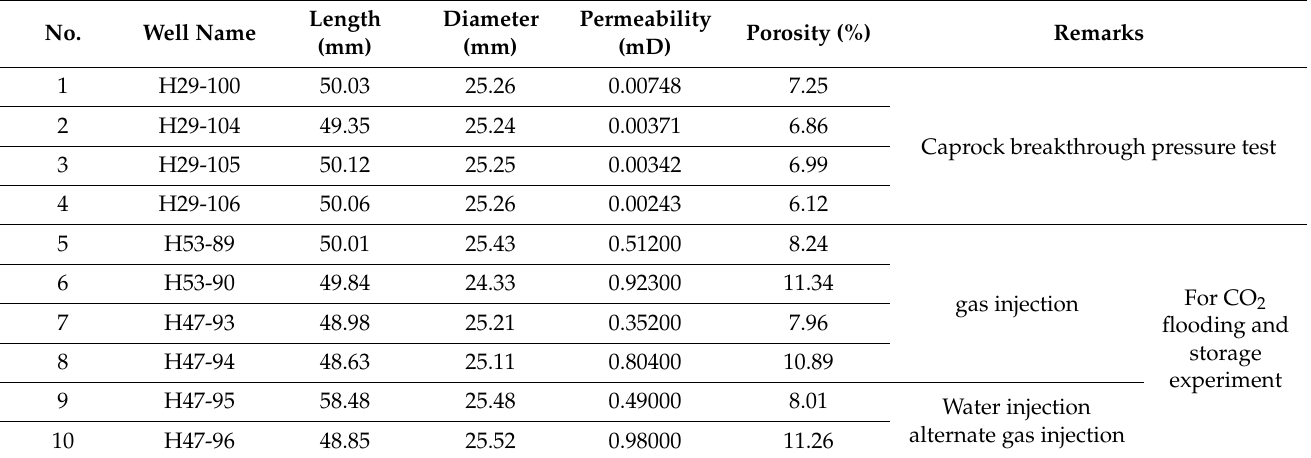
Table 1. The petrophysical parameters of experimental cores.